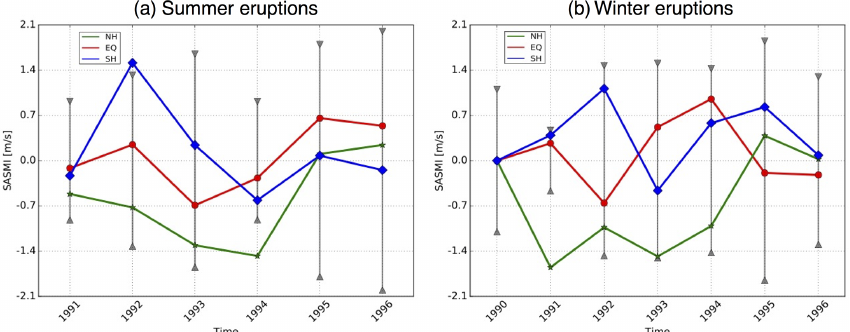
Figure 7. South Asian summer monsoon index (ms − 1 ) anomaly for the summer eruption cases (a) and the winter eruption cases (b) . The grey bar indicates 1 standard deviation of the control runs.